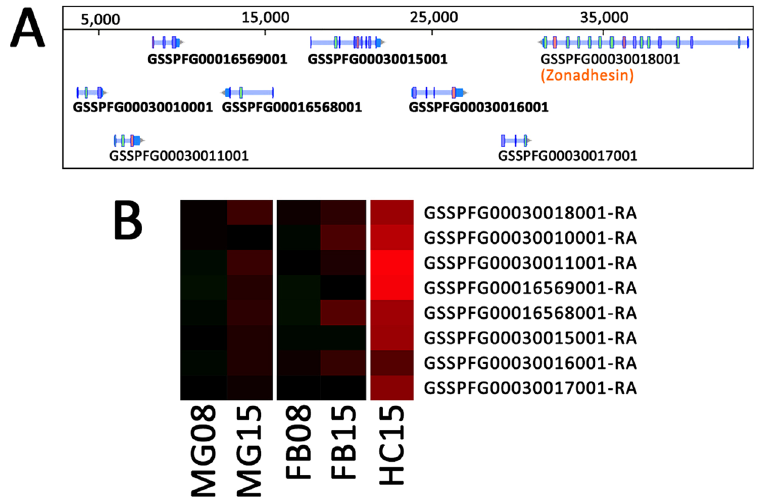
Figure 4. Inducible MetalloProtease Inhibitor. ( A ) WebApollo viewer showing the annotation of inducible metalloprotease inhibitors genes in cluster on the scaffold_1741 in the genome of Spodoptera frugiperda . ( B ) As in Fig. 2, heatmap of differential expression for the identified IMPI